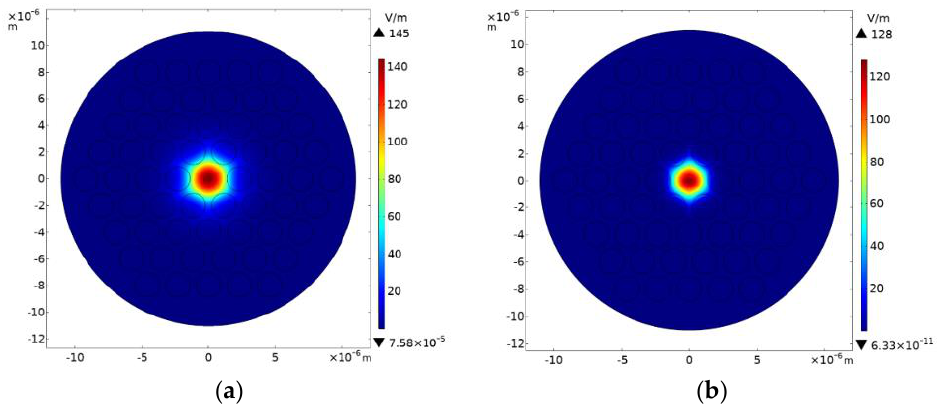
Figure 3. Distribution of optical fundamental mode in the proposed ( a ) filled and ( b ) unfilled PCF at 20 °C.